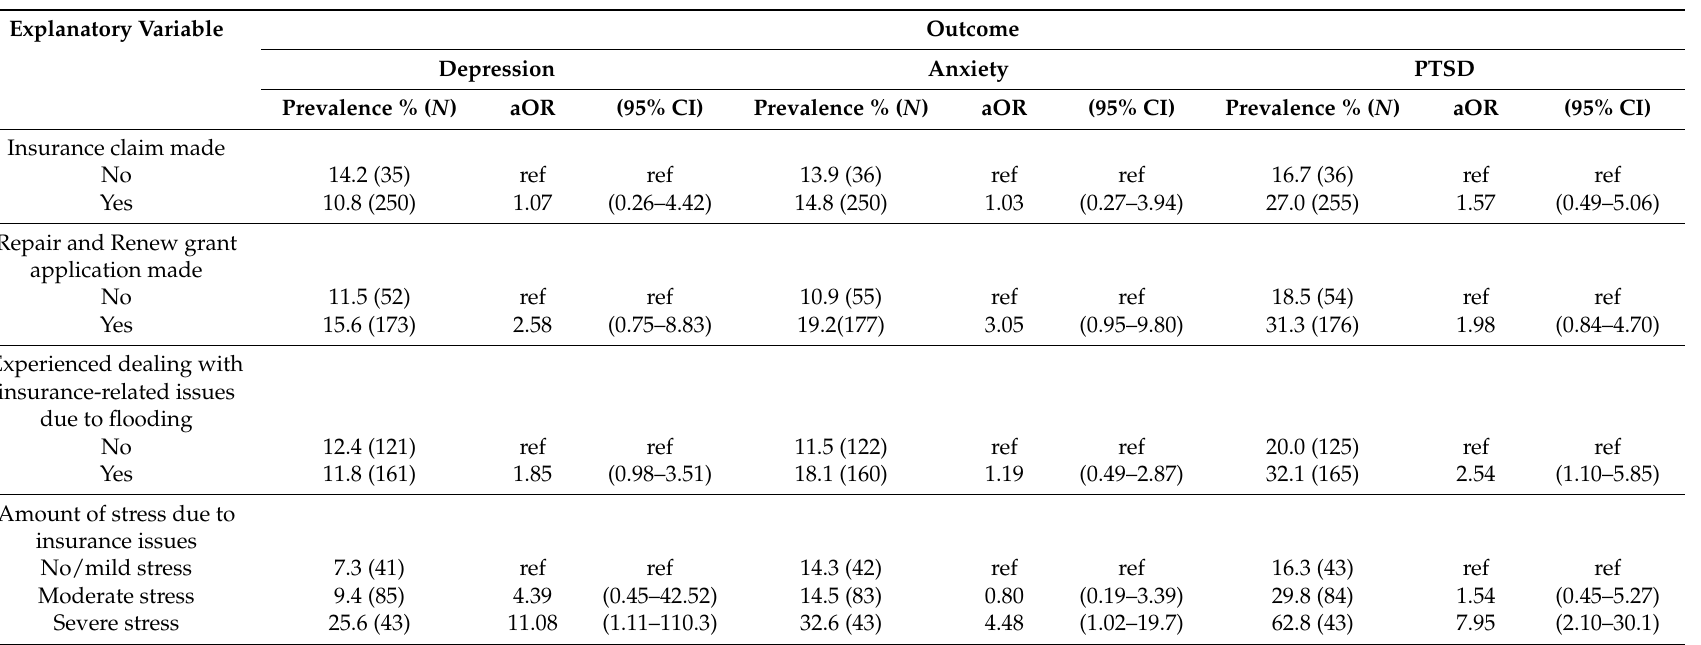
Table 3. Association between probable mental health outcomes and insurance-related factors for flooded